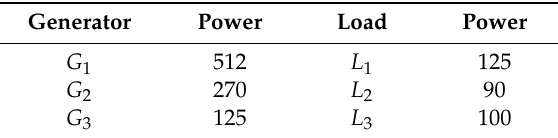
Table 1. Weight values for G and L